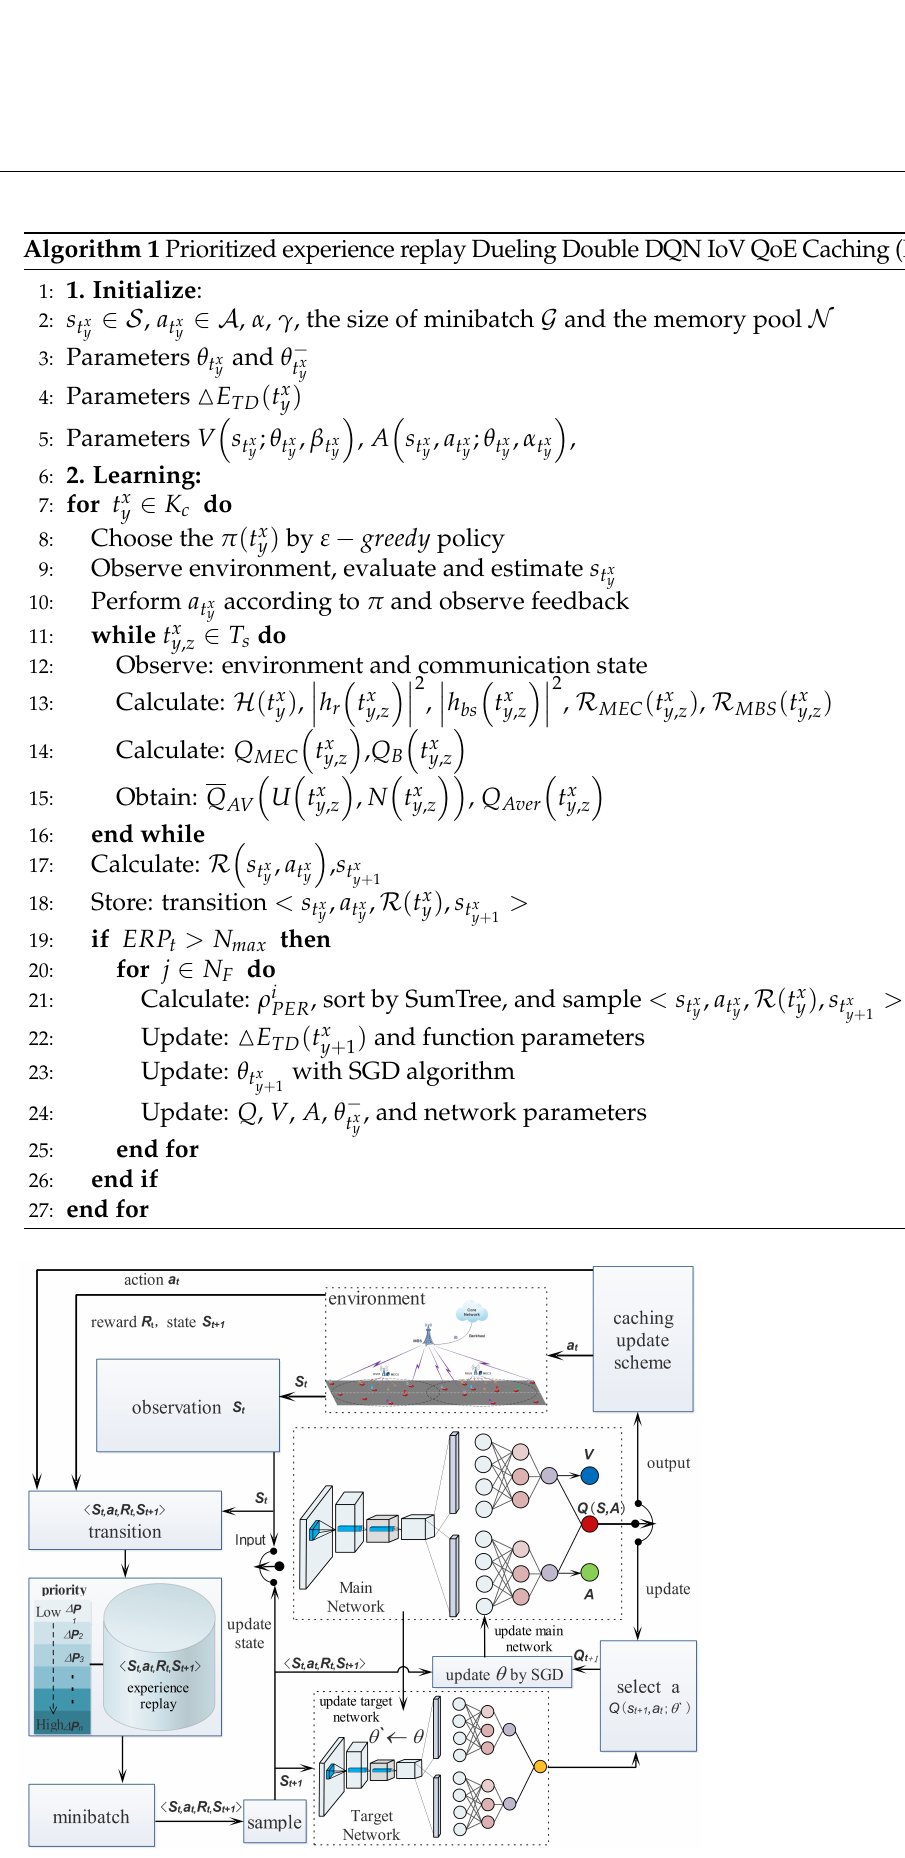
Figure 3. The proposed